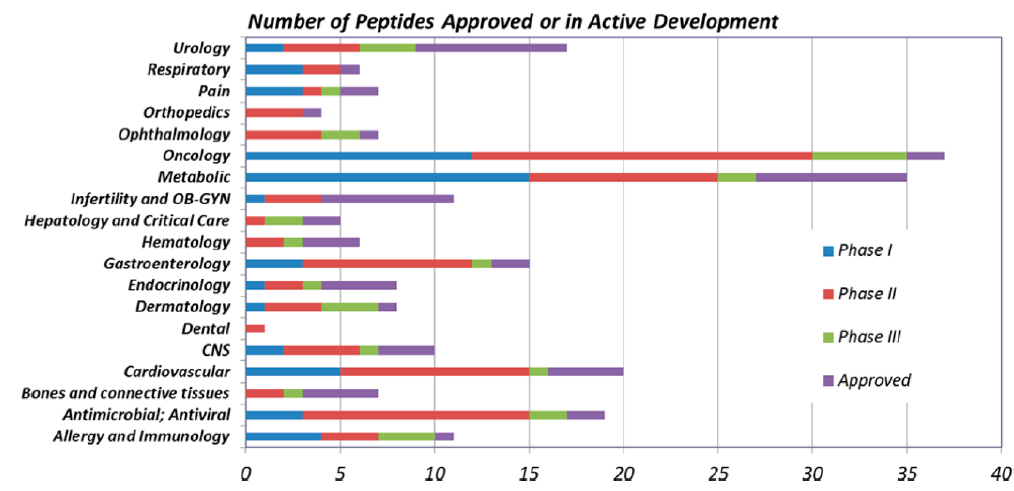
Figure 1. Peptides approved and in active development by therapeutic area (2016) [6].